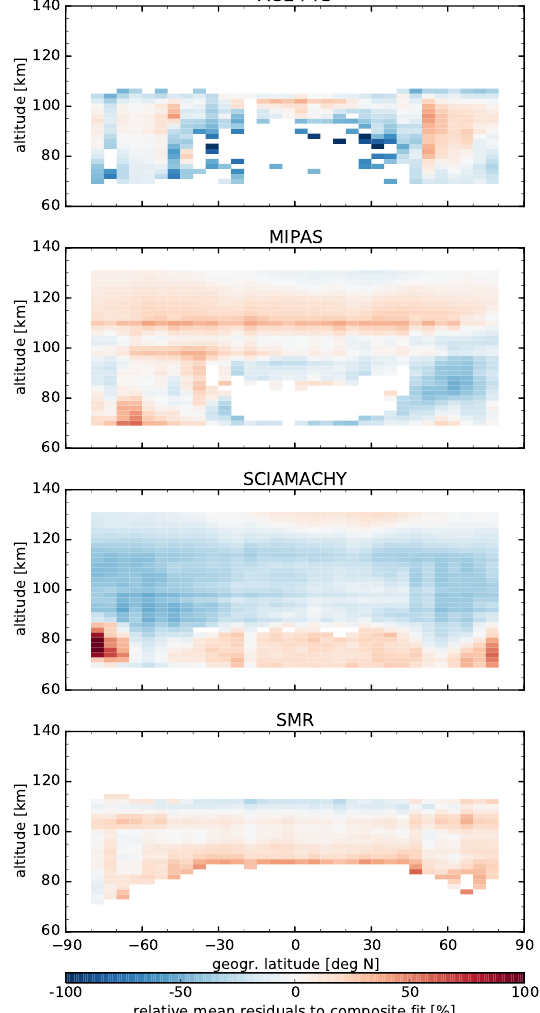
Figure 16. NO regression coefficient d 1 of the annual cycle (cosine part). Shown are all values above the 95% significance level of the coefficient calculated using the t